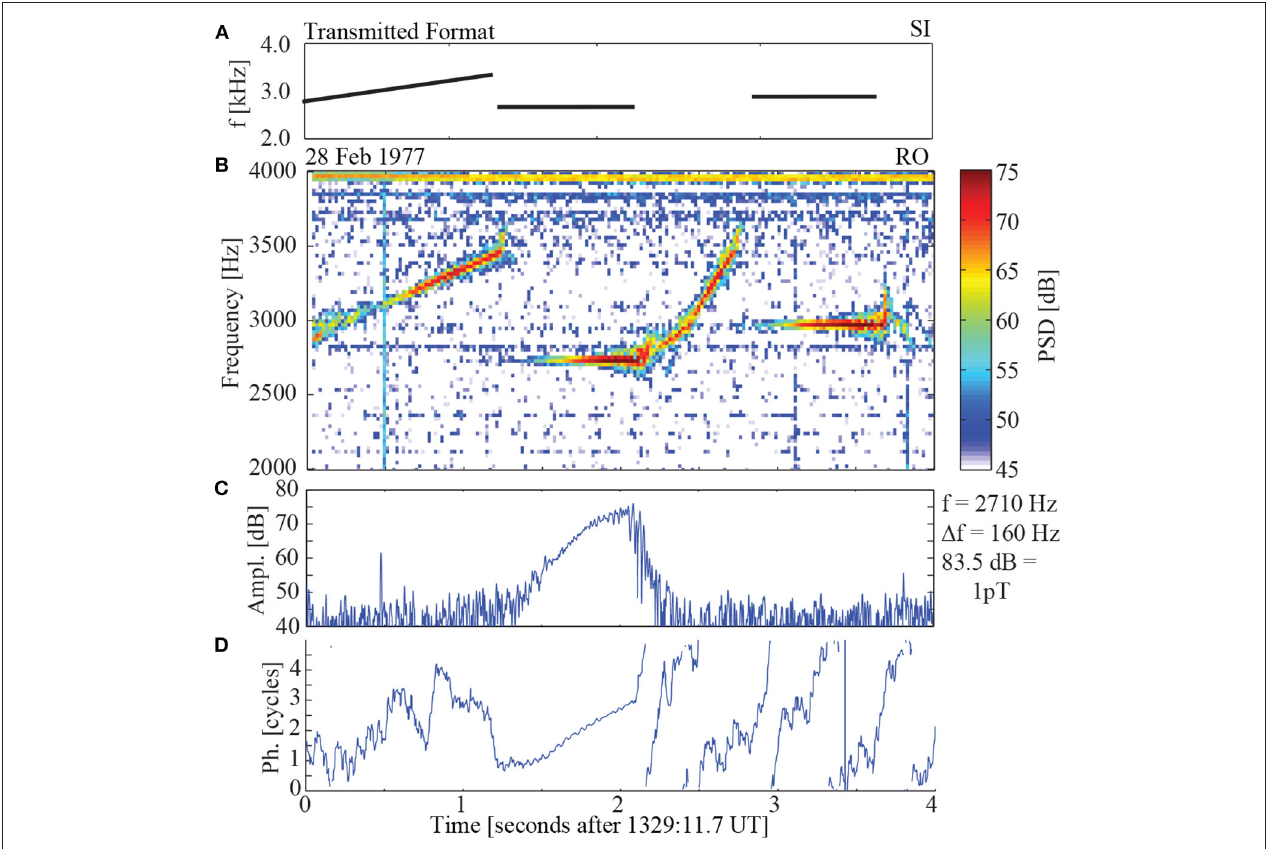
FIGURE 2 | Growth and triggering characteristics of the instability from the Siple Station experiment seen in the transmission of 2.71 kHz pulse (A) The time frequency format transmitted from Siple Station. (B) The time-frequency spectrogram of the VLF data received at the conjugate point. (C) A narrowband amplitude plot, centered on 2.71 kHz, with a 160 Hz bandwidth. (D) The phase of the narrowband data in (C) . Adapted from Figure 2.3 of Gibby